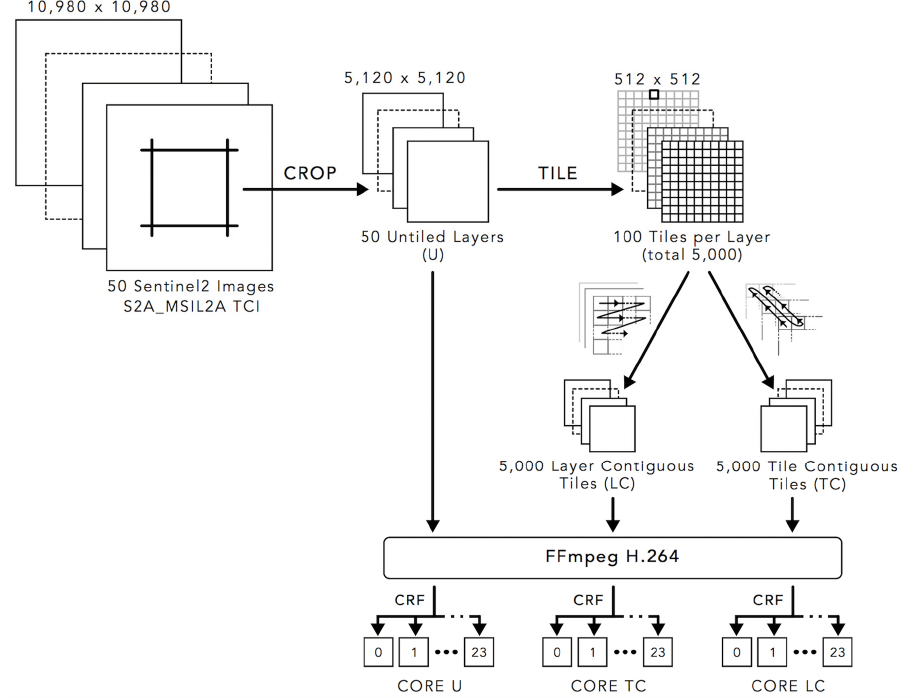
Figure 1. Methodology overview for creating CORE